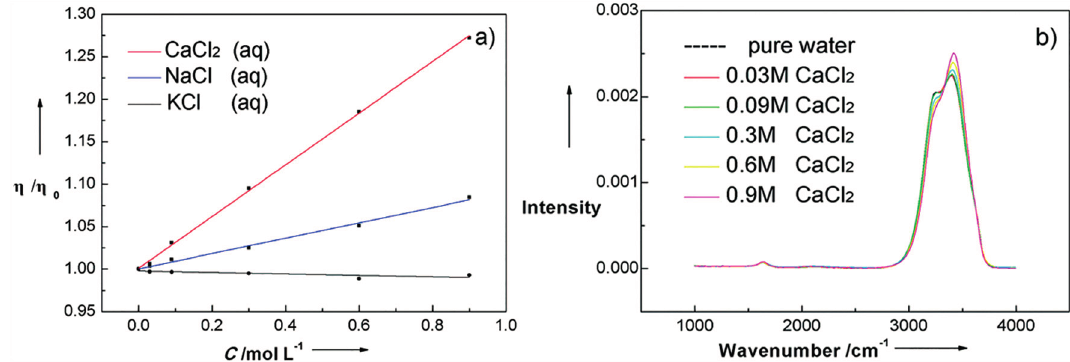
Figure 7. ( a ) Viscosity changes of three aqueous solutions with concentration. Among the three aqueous solutions, CaCl 2 (aq) has stronger ability in elevating water viscosity; ( b ) Comparison of Raman stretching vibration spectrums of CaCl 2 aqueous solutions with different concentrations. The Raman spectrum are normalized to have identical area from 2800 to 3800 cm − 1 to facilitate the